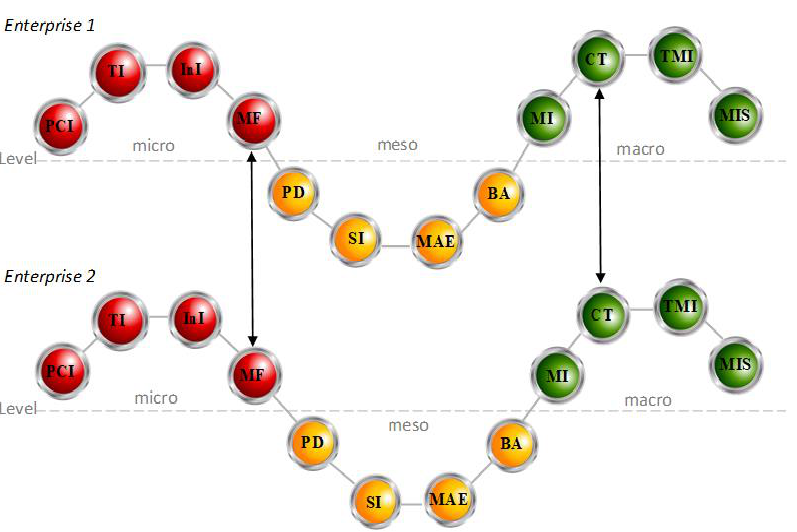
Figure 1. Pair replication of the integrated enterprise development. Note: PCI — Indicator of Pro- duction Capacities Integration; TI — Indicator of Technological Integration; InI — Information inte- gration indicator; MF — Indicator of Management Flexibility; PD — Level of Production Diversifica- tion; SI — Indicator of Scientific Integration; MAE — Indicator of the Marketing Activities Efficiency; BA — Business Activity Indicator; MI — Market Integration Indicator; CT — Consumer Tolerance In- dicator; TMI — Target Market Integration Indicator; MIS — Maneuverability Indicator of the Inte- grated Structure. Source: Formed by the authors.